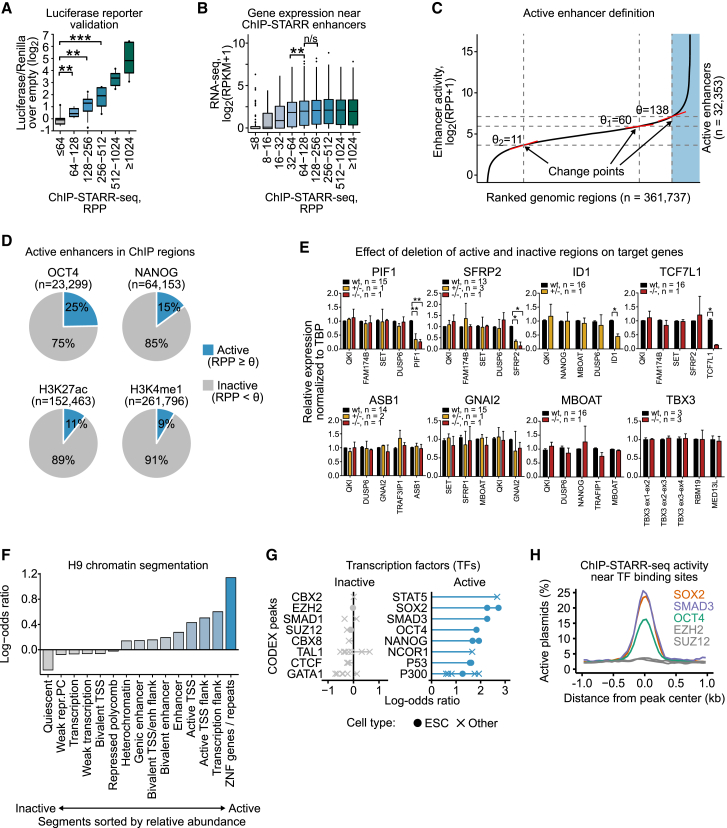
Activity Levels Define Functional Classes of Enhancers(A) Luciferase activities of 68 genomic sequences in primed ESCs grouped by ChIP-STARR-seq activity. Boxes are interquartile range (IQR); line is median; and whiskers are the 10th to the 90th percentile. ∗p < 0.05; ∗∗p < 0.01; ∗∗∗p < 0.001; Mann-Whitney test; n = 2.(B) Distribution of expression values (Takashima et al., 2014) of genes associated with enhancers grouped by activity level. Boxes are IQR; line is median; whiskers extend to 1.5× the IQR; and dots are outliers. ∗∗p < 0.01; ∗∗∗p < 0.001; unpaired t test.(C) Plot showing enhancer activity (enrichment of ChIP-STARR-seq RNA over plasmids; log2) ranked from lowest to highest across all measured enhancers (union of all peak calls). Enhancers were distinguished based on activity; dashed lines indicate thresholds (θ).(D) Distribution of active (RPP ≥ 138) and inactive sequences (RPP < 138) in peaks called for the indicated factors.(E) qRT-PCR analysis of wild-type (WT) and enhancer-deleted heterozygous (+/−) or homozygous (−/−) ESC clones. Indicated mRNAs are normalized to TBP (WT = 1), and the average results for the indicated deletions are plotted relative to wild-type; n = number of cell lines per genotype (see STAR Methods for further details). ∗p < 0.05; ∗∗p < 0.01; ∗∗∗p < 0.001 (two-way ANOVA, Bonferroni post-test). Error bars represent SD.(F) Relative enrichment of H9 chromatin segment overlaps (Kundaje et al., 2015) between regions with ChIP-STARR-seq activity and inactive regions (see C).(G) Relative LOLA enrichment of TFs from CODEX (Sánchez-Castillo et al., 2015) in inactive regions and active enhancers. Odds ratios between observed frequencies of enhancers overlapping binding sites for the eight most enriched TFs in the respective groups relative to the percentage in the entire region set are shown, ranked by mean odds ratio. Each dot represents a TF ChIP-seq dataset. ChIP-seq datasets from non-ESCs are shown as crosses.(H) Smooth line plots of the proportion of active plasmids (RPP ≥ 138) around the peak center for the indicated ChIP-seq binding sites.